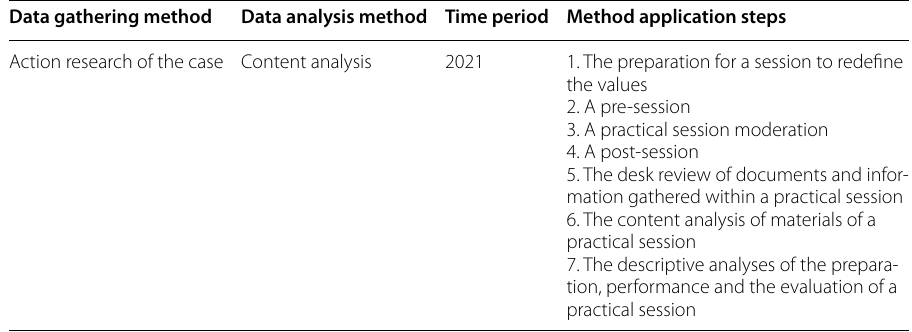
Table 4 Case study steps. Source: developed by the authors Data gathering